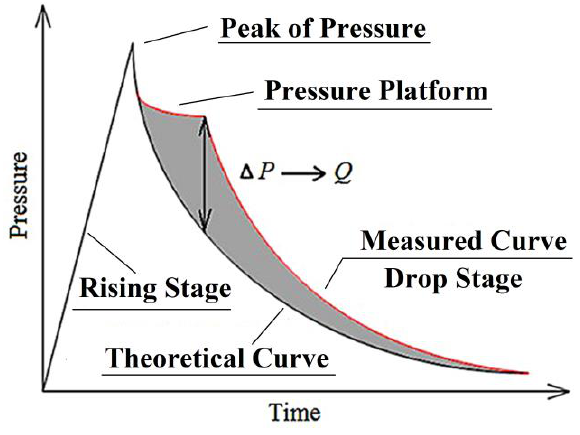
Figure 13. The graphic of the test curve.